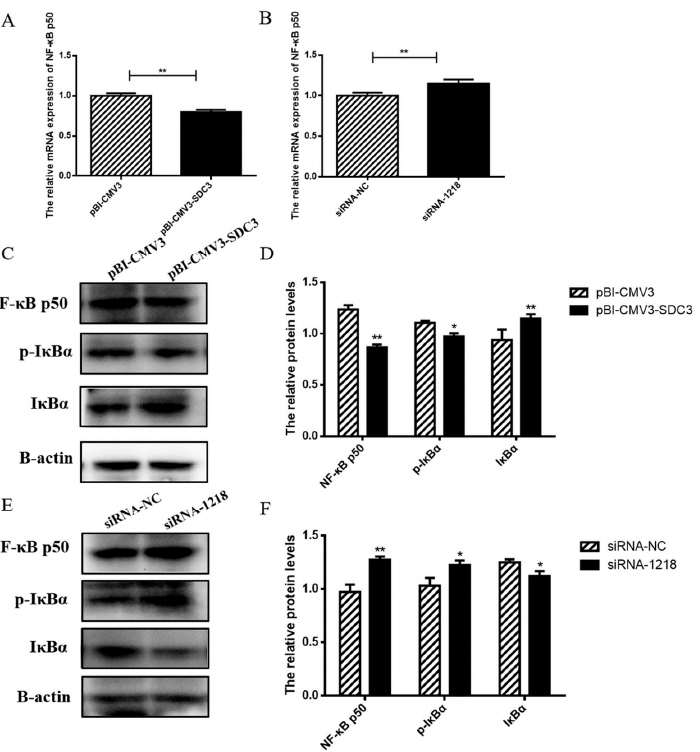
Figure 5. SDC3 is a negative regulator of the NF- κ B signaling pathway. pBI-CMV3-SDC3 vector or siRNA-1218, was transfected into BMECs. ( A , B ) RT-qPCR was used to detect the transcriptional levels of NF- κ B p50 . ( C , E ) The expression levels of NF- κ B p50 , Phospho-I κ B Alpha ( P-I κ B α ), and I κ B α in all groups of BMECs were examined using Western blot. ( D , F ) Relative folds of NF- κ B p50 , P-I κ B α , and I κ B α protein levels (protein/ β -actin) from the Western blots, quantified by gray scale scan. Data are presented as means ± SD (n = 3). Statistically significant differences are indicated: * p < 0.05, ** p < 0.01. pBI-CMV3, siRNA-NC = nonspecific scrambled control.